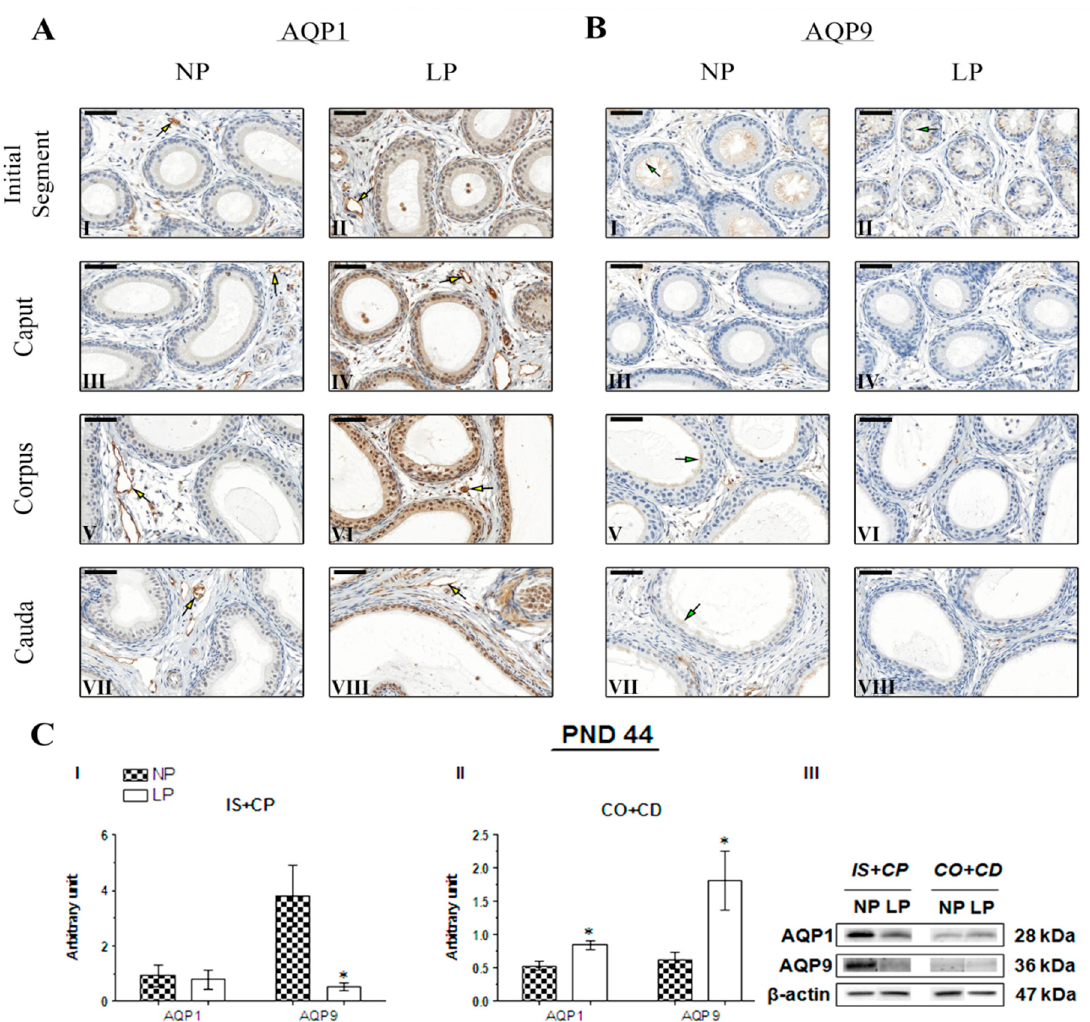
Figure 5. Expression and immunolocalization of AQP1 and AQP9 in the epididymis of 44 ‐ day ‐ old animals. ( A ) Immunoreactivity for AQP1 in endothelial cells of vascular channels in the initial segment ( I and II ), caput ( III and IV ), corpus ( V and VI ) and cauda ( VII and VIII ) of NP and LP animals (yellow arrows). ( B ) Immunoreactivity for AQP9 in the stereocilia of epididymis principal cells in the initial segment ( I and II ), caput ( III and IV ), corpus ( V and VI ) and cauda ( VII and VIII ) of NP and LP animals (green arrows). Bar = 50 μ m. ( C ) Extracts obtained from individual animals were used for a densitometry analysis of the levels of the proteins in the initial segment plus caput ( I ) and corpus plus cauda ( II ) following normalization to the housekeeping protein β‐ actin. Representative blots showing the levels of the AQP1, AQP9 and β‐ actin proteins ( III , right panel). Data are presented as means ± S.E.M. * p < 0.05, Mann ‐ Whitney test.